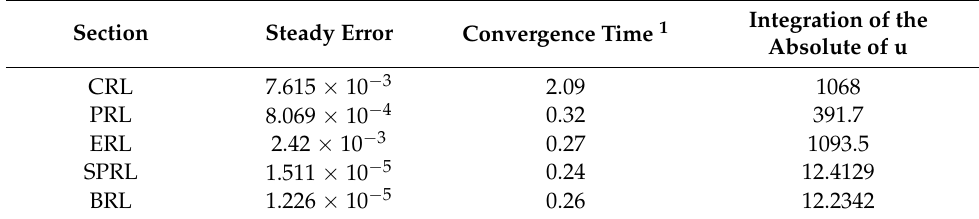
Figure 6. Sliding mode motions for different reaching laws under sinusoidal signals. Table 2. Quantitative comparison of results of sinusoidal